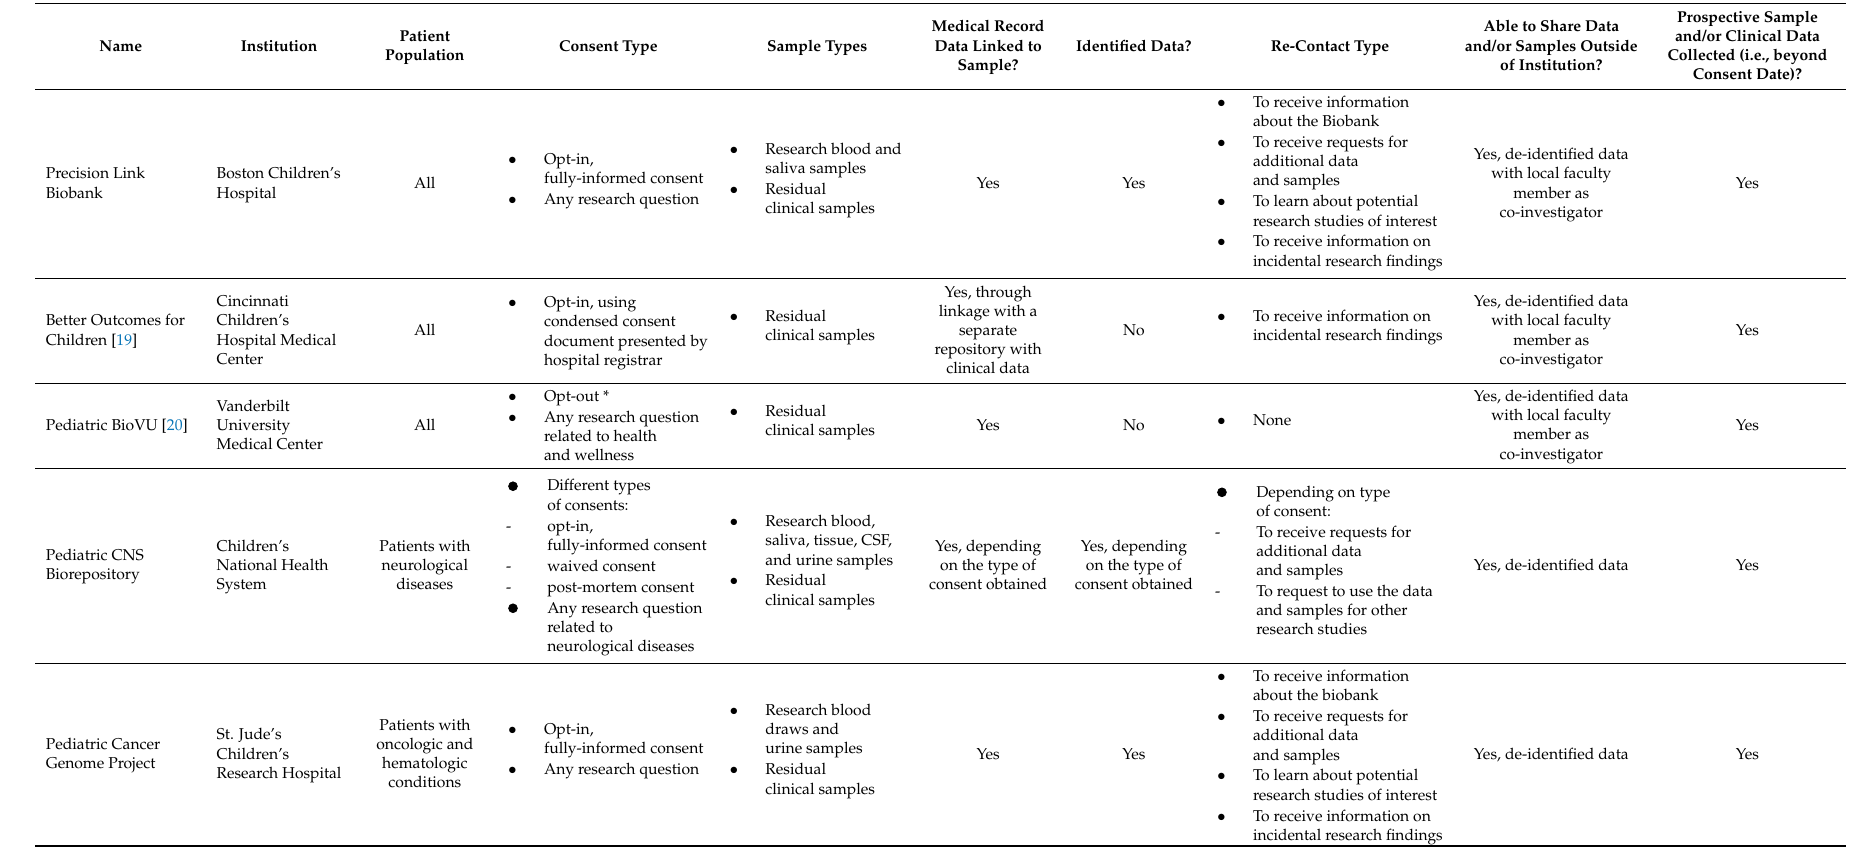
Table 2. Features of selected U.S.-based pediatric